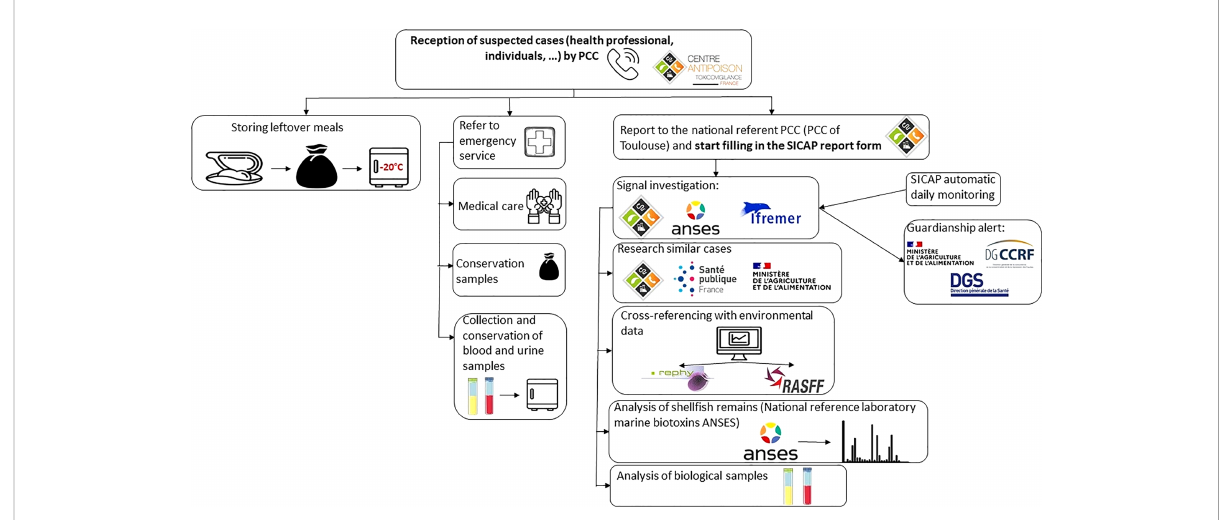
FIGURE 1 Scheme for the management of a suspected case of shell fi sh poisonings following the developed prospective surveillance in